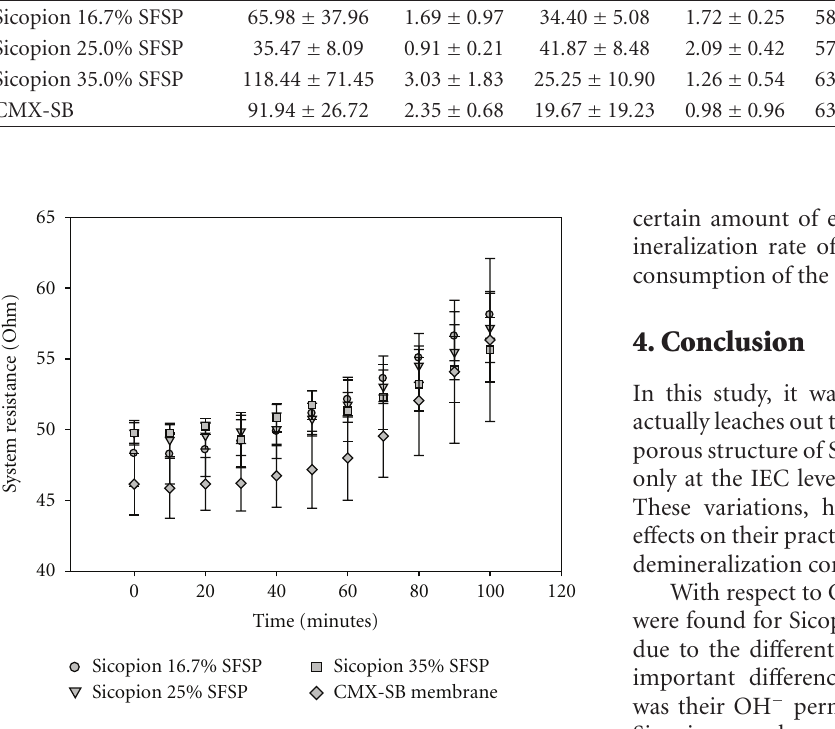
Figure 14: Resistance evolution of the ED stacks during the 100- minute demineralization procedure. Membranes specified in the legend indicate the CEM defining the diluate